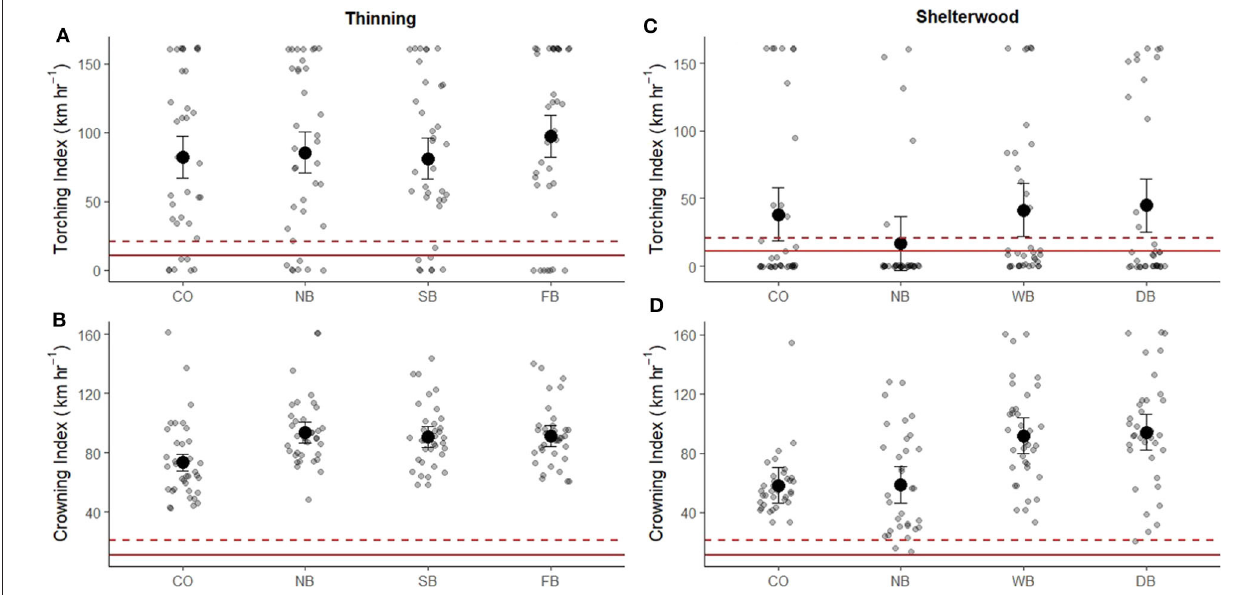
FIGURE 8 | Torching and crowning indices and wind speeds in the Thinning (A,B) and Retention Shelterwood (C,D) 22 years post-treatment (2015). Treatment means and standard error in black; individual plots in grey. Red lines are median wind gusts (dashed) and median daily average (solid) during July through September. No treatment differences were detected ( α = 0.05). Treatments: CO = Control, NB = Cut, No Burn, SB = Cut + Spring Burn, FB = Cut + Fall Burn, WB = Cut + Wet Burn, and DB = Cut + Dry